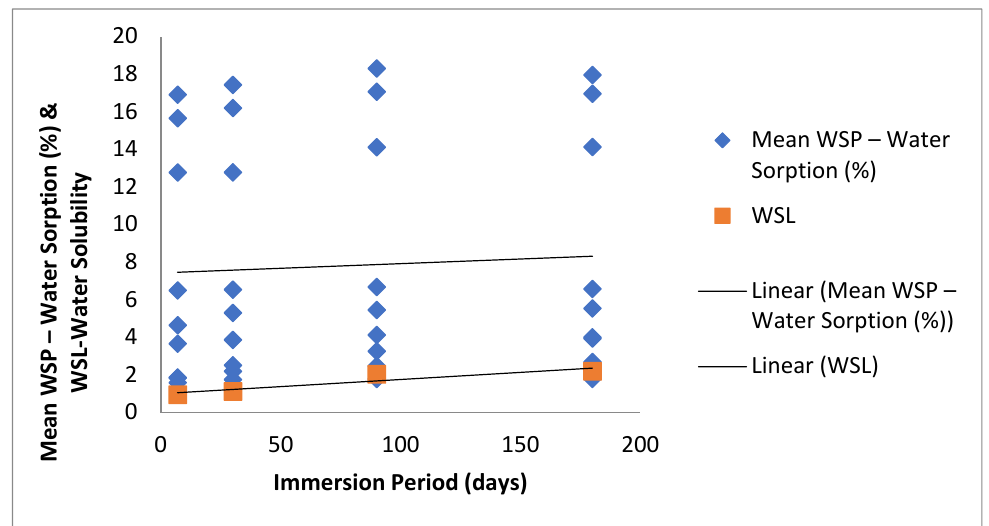
Figure 1. Trends in Water-Sorption (%) and Water-Solubility (%) among material for study duration (days).